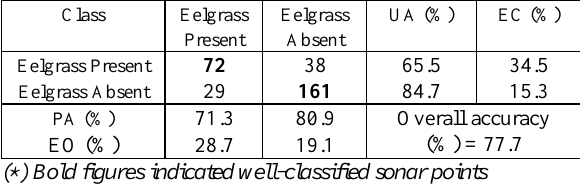
Table 9. Confusion matrix (in GPS sonar points) and associated accuracies when the Sentinel-2 RF